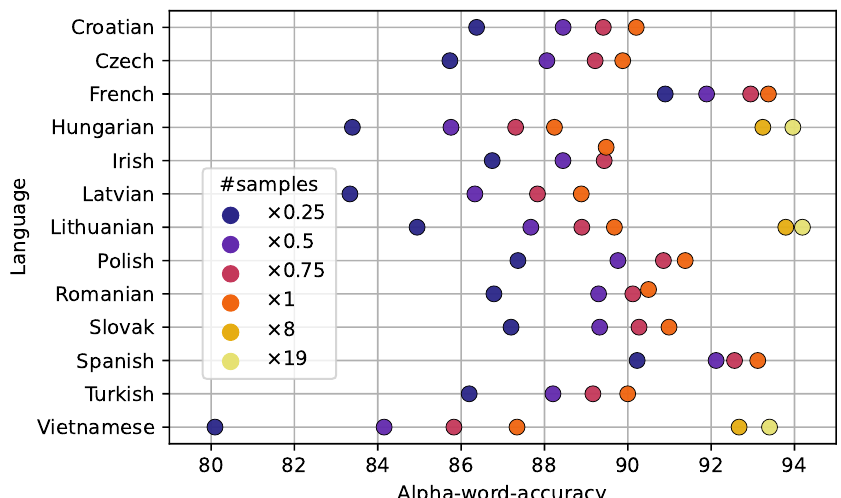
Figure 3. Alpha-word accuracy improvement during diacritics and typographical errors correction training. Training data of × 1 corresponds to 2048 × 256 sentences for a given language. We also run a single longer training session for the Hungarian language, with up to × 19 training